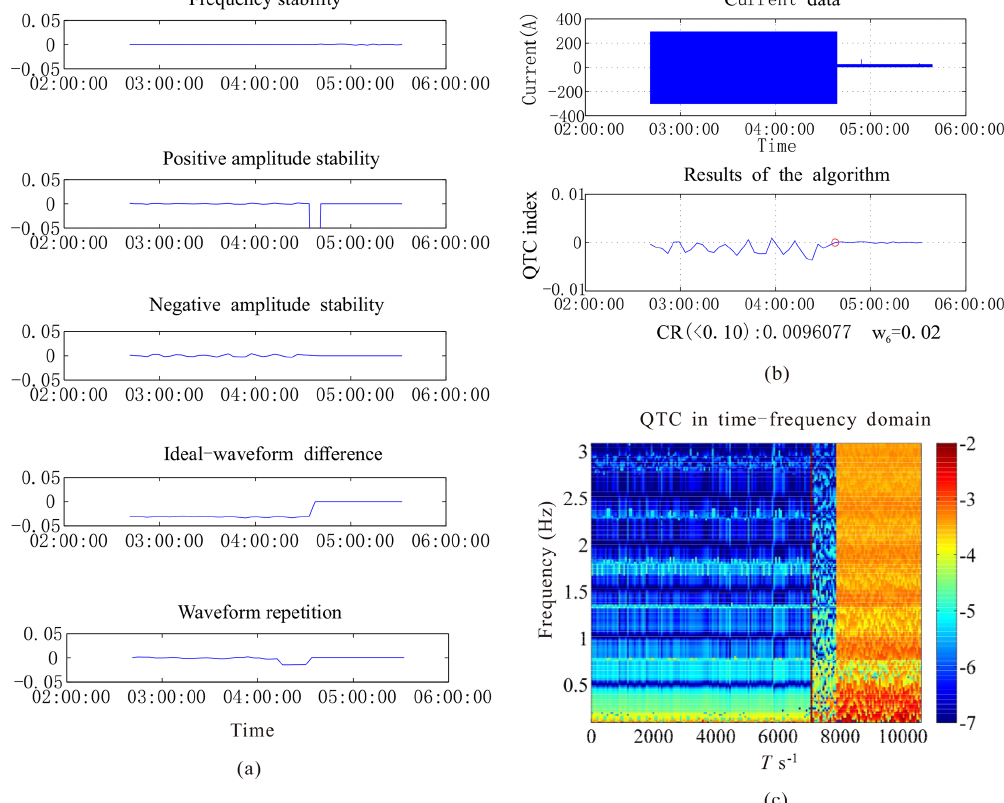
Figure 3. Comprehensive analysis results of sea trial data in